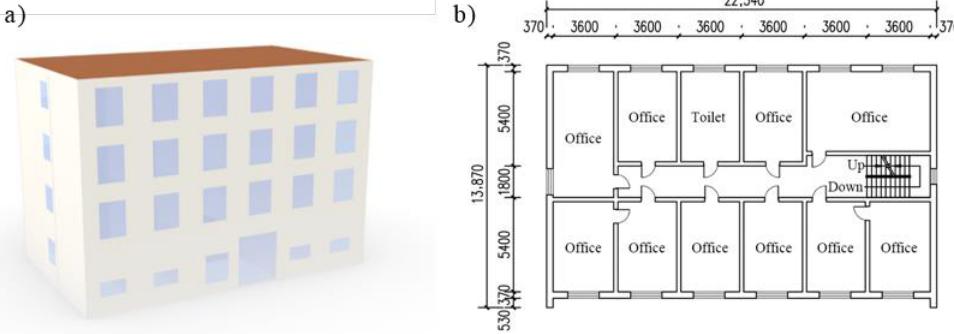
Figure 8. The typical building model and its plan: ( a ) the model; ( b ) the